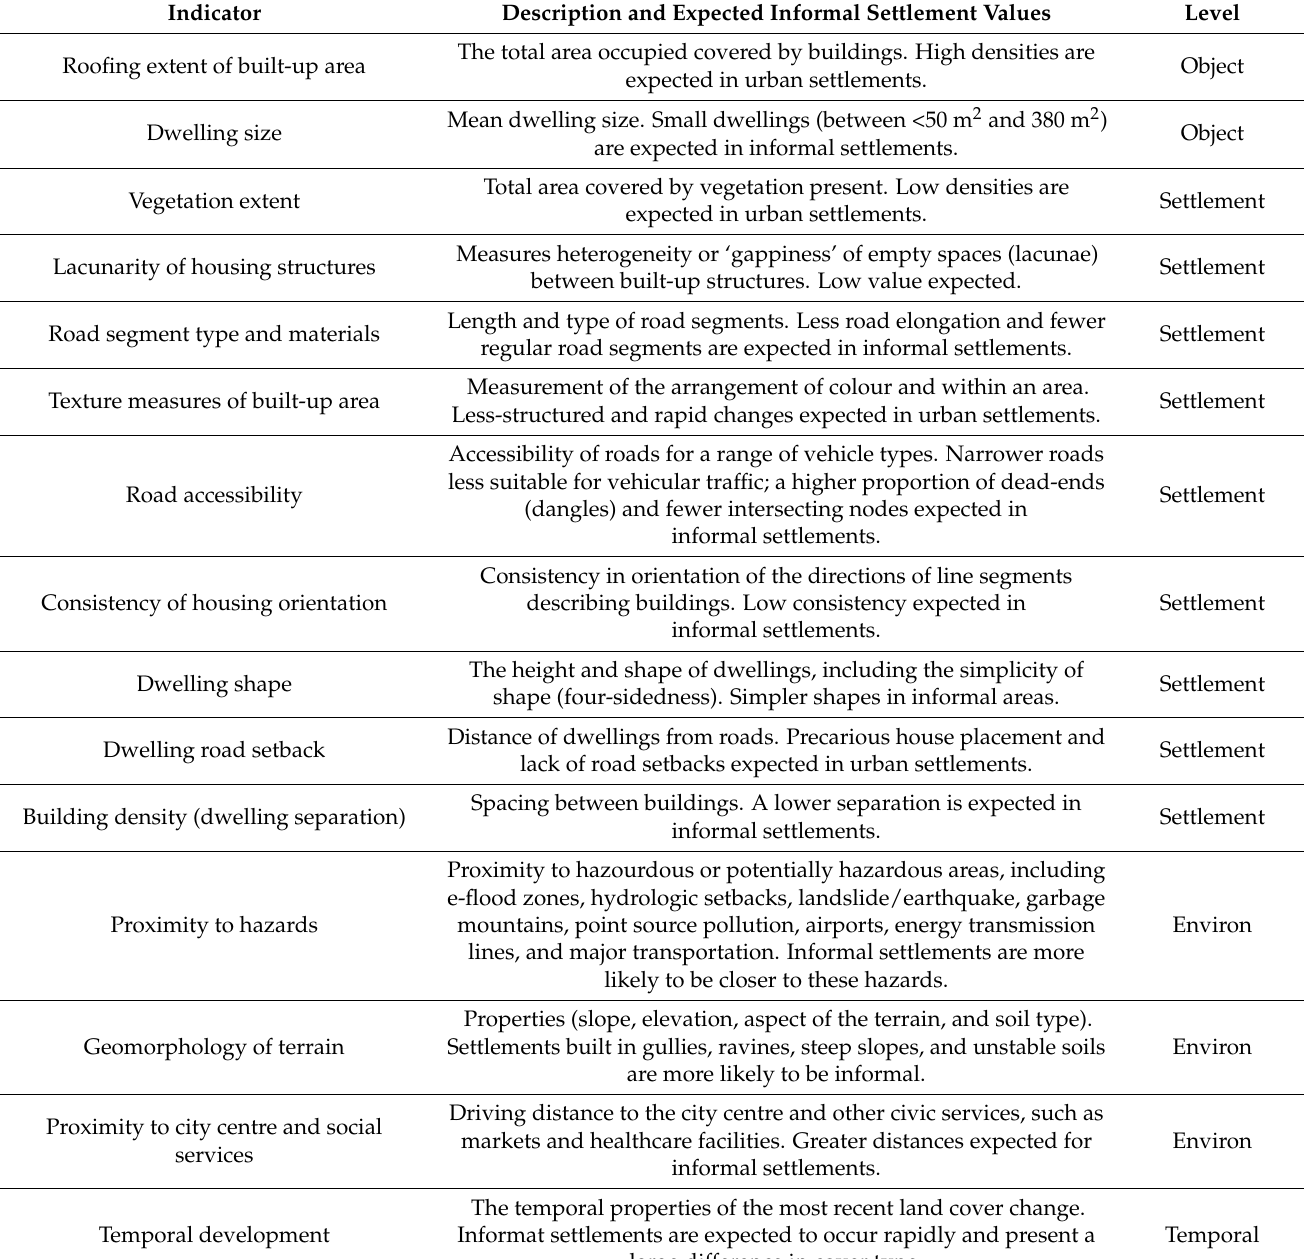
Table 1. The indicators of informal settlements considered in this study including temporal level as a new dimensional level to informal settlement mapping (adapted from [46]). For full details of the parameters and indices used for mapping informal settlements, see